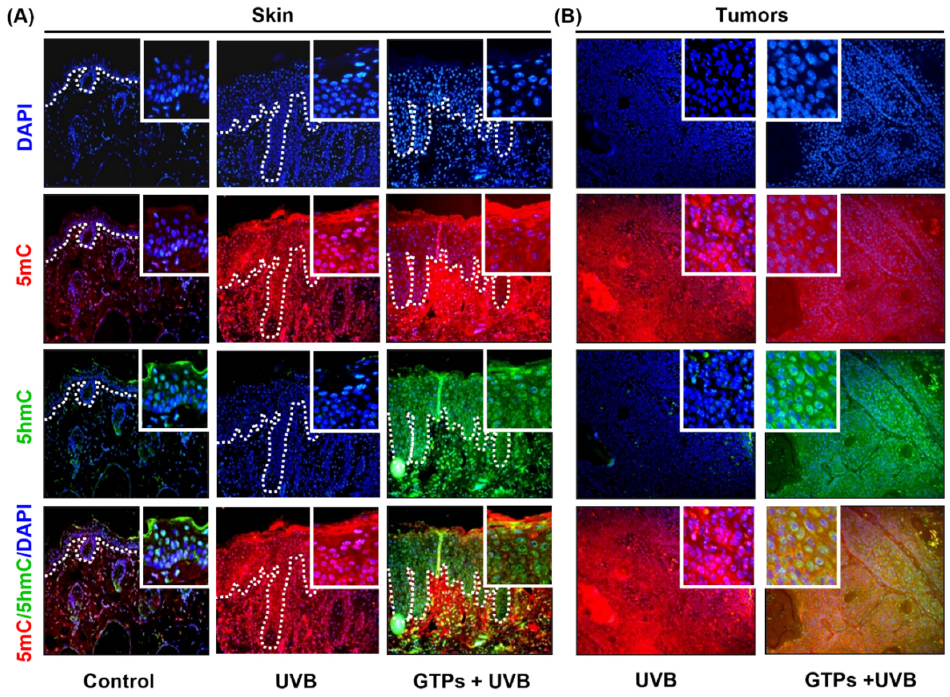
Figure 3. Effect of GTPs on the expression levels of 5mC and 5hmC in UVB-exposed skin and tumors of SKH-1 hairless mice. To define the occurrence of the UVB-induced tumor, the epidermis is demarcated by the dotted white line. The expression of 5mC (red), 5hmC (green), and colocalization (yellow) in the skin ( A ) and tumors ( B ) ( n = 6).